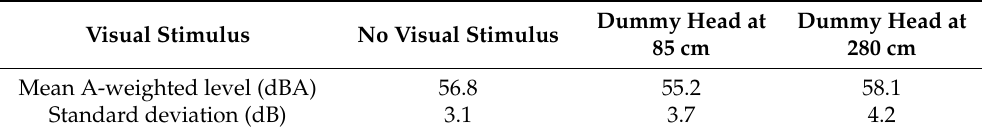
Table 8. Marginal means and standard deviations of the groups at three different levels of the visual stimulus in the reading part of the